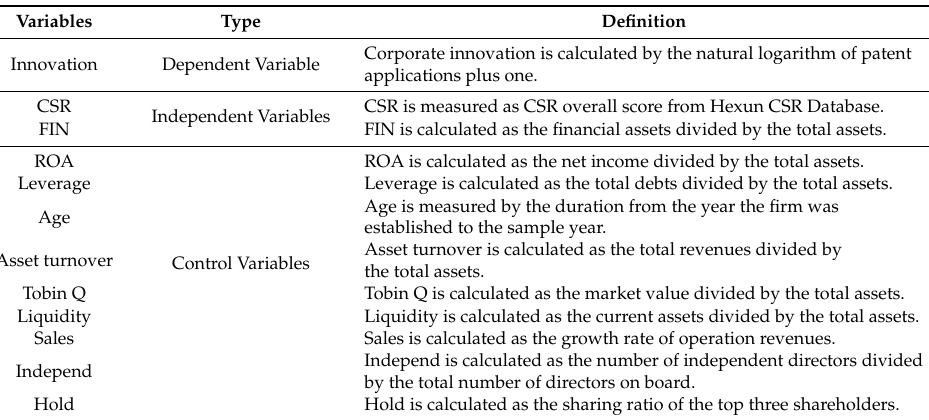
Table 1. Variable